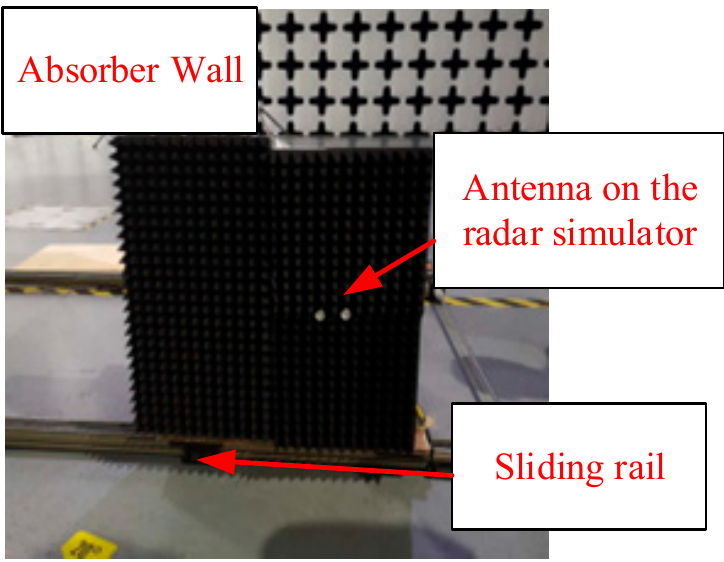
Figure 3. ACC function test in an anechoic chamber using a radar simulator on rail.